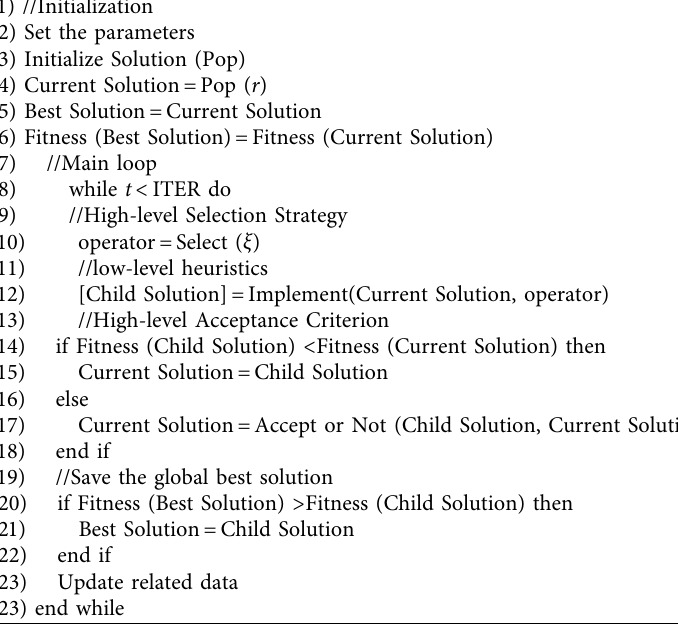
Table 3: Pseudocode of the HH.